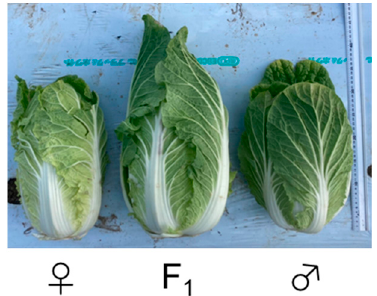
Figure 5. Heterosis of head size in an F 1 hybrid of Chinese cabbage.